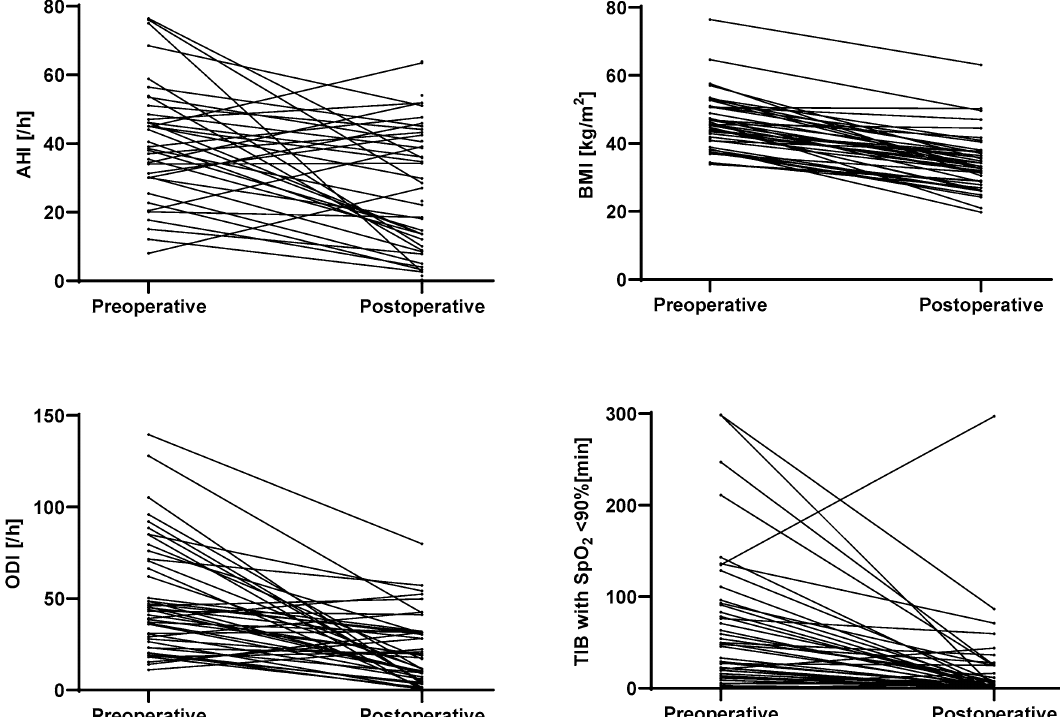
Figure 2. Perioperative changes in apnea–hypopnea index, oxygen desaturation index, body mass index and time in bed with hemoglobin saturation below 90%. AHI, apnea–hypopnea index; BMI, body mass index; ODI, oxygen desaturation index; TIB, time in bed; SpO 2 , hemoglobin oxygen